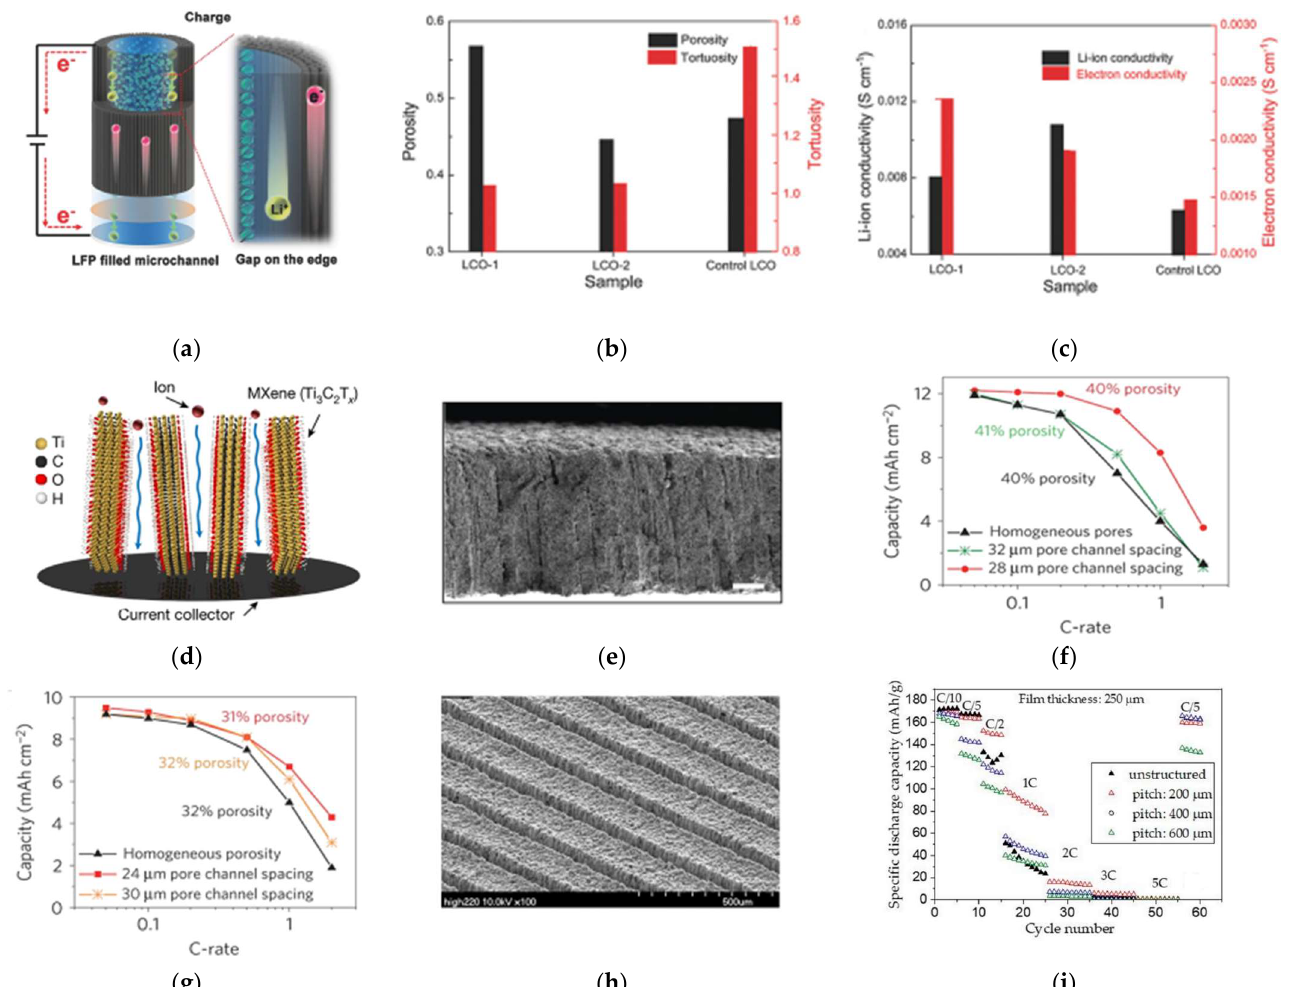
Figure 9. ( a ) Graphical illustrations of the ion and electron transportation behavior occurring in the wood−templated electrodes [52]. The comparison of LCO−1, LCO−2, and control LCO in terms of ( b ) tortuosity and porosity, ( c ) Li−ion and electron conductivities [92]. ( d ) Schematic illustration of ion transport in vertically aligned Ti 3 C 2 T x MXene films [32]. ( e ) Cross−sectional SEM image of a low tortuosity LCO electrode constructed by magnetic method [94]. Areal capacity versus C−rate for LCO electrodes with pore channels: ( f ) 310−μm−thick electrodes with 39−42% porosity and ( g ) 220−μm−thick electrodes with 30−32% porosity [95]. ( h ) SEM images for laser−structured electrodes (thickness ≈ 210 μm ) [101]. ( i ) Specific discharge capacity of cells containing 250 μm thick electrodes with different pitch distances [105].